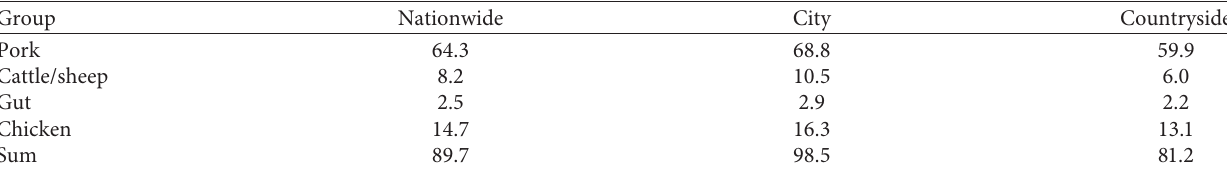
Table 1: Main food intake of Chinese residents in 2012 (g/d •